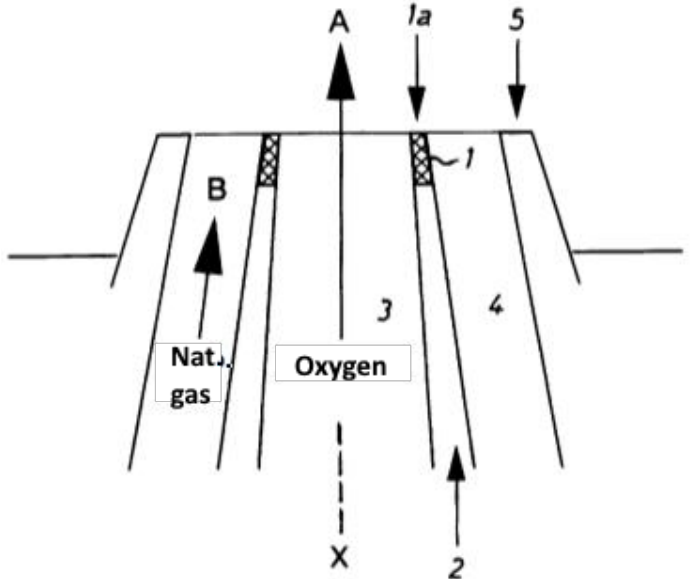
Figure 4. Schematic diagram of a Shell burner for the high - pressure POX process [70]: 1—the upper part of the partition separating the channels, 1a—the outer part of the partition separating the channels, 2—the partition separating the channels, 3—central channel for supplying oxidant, 4—external channel for supplying natural gas, 5—outer wall of the burner.